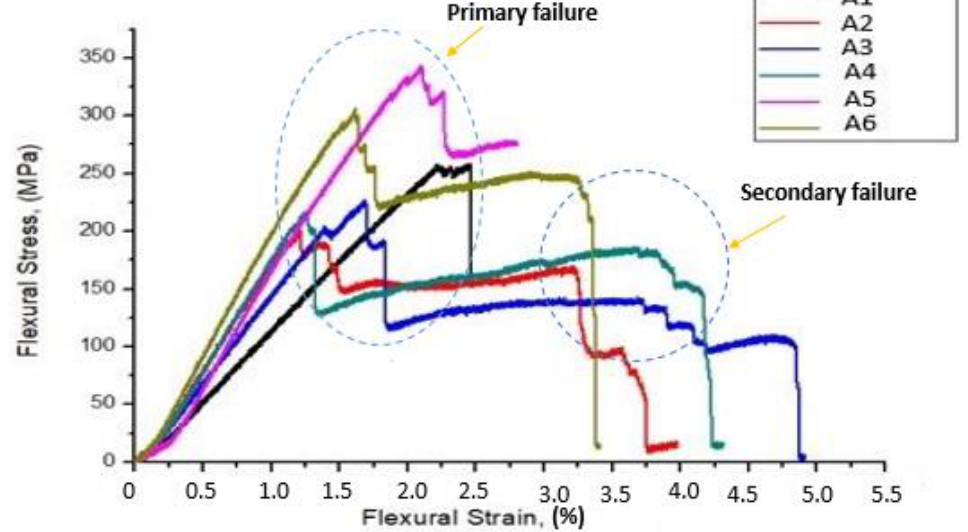
Figure 4. Stress vs. strain variation of GF/SF/CTS composite scaffolds under a three-point bending test.